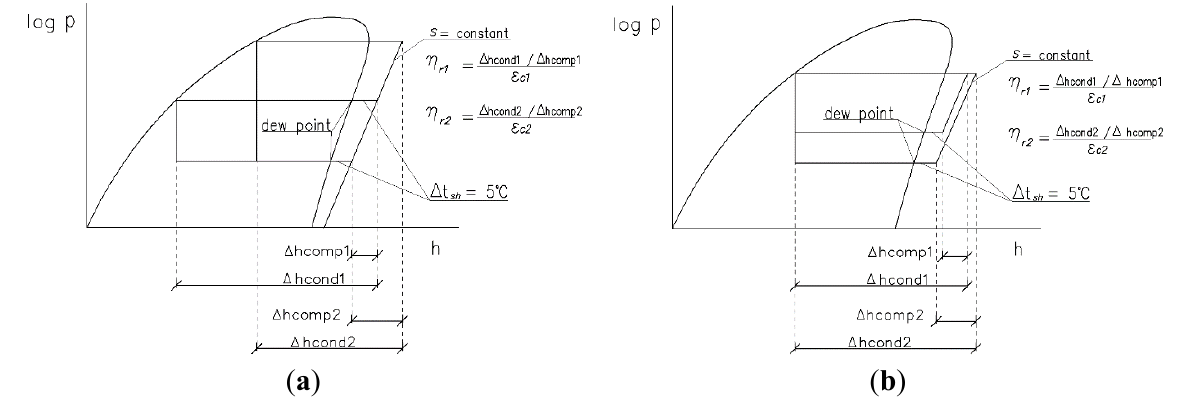
Figure 5. Defining the thermodynamic efficiency of the refrigerant: ( a ) the evaporating temperature is constant; and ( b ) the condensing temperature is